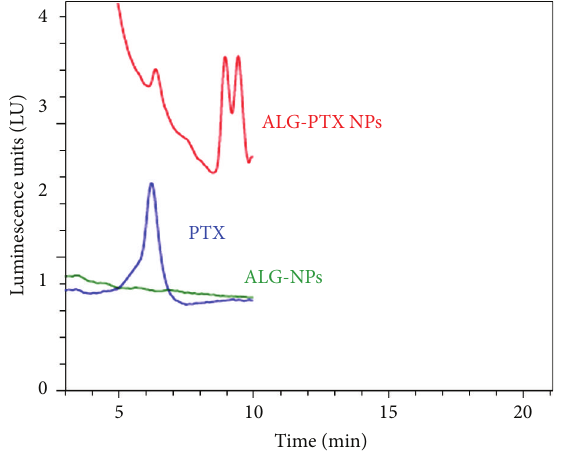
Figure 2: TEM images obtained for purified nanoparticle preparations. (a) HPLC isolated ALG nanoparticles. (b) HPLC isolated PTX-ALG nanoparticles. (c) High-power view of (b) inset represents high-power magnification view of the PTX-ALG nanoparticles.